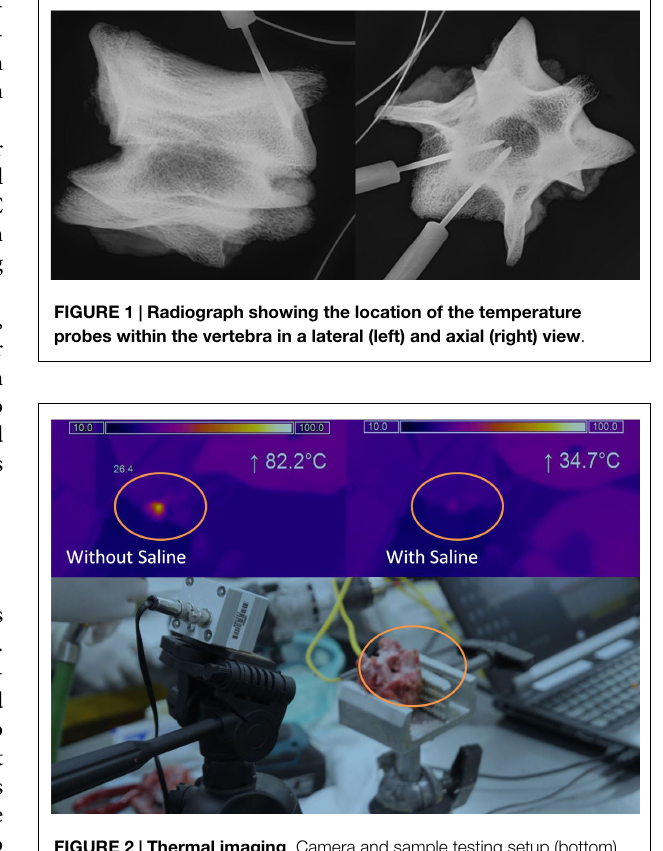
FIGURE 2 | Thermal imaging . Camera and sample testing setup (bottom), Thermal imaging result without saline (top left), Thermal imaging result with saline (top right). Orange circle indicates the same area for the different